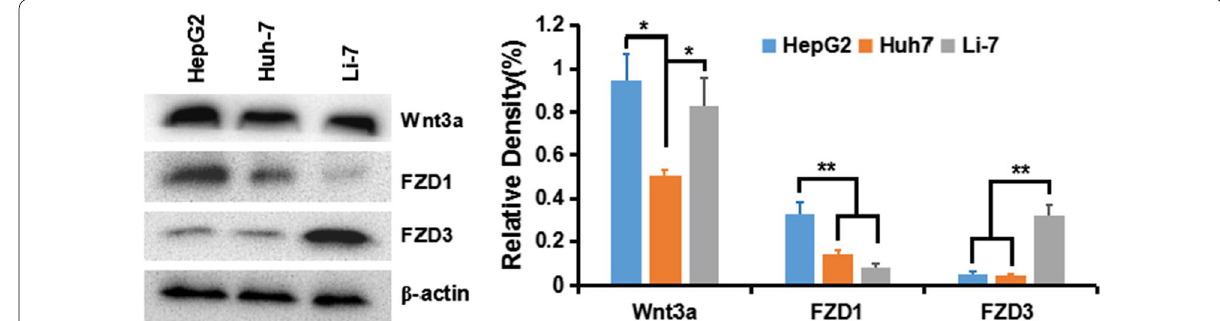
Fig. 5 Expression of Wnt3a, FZD1, and FZD3 in HCC cell lines